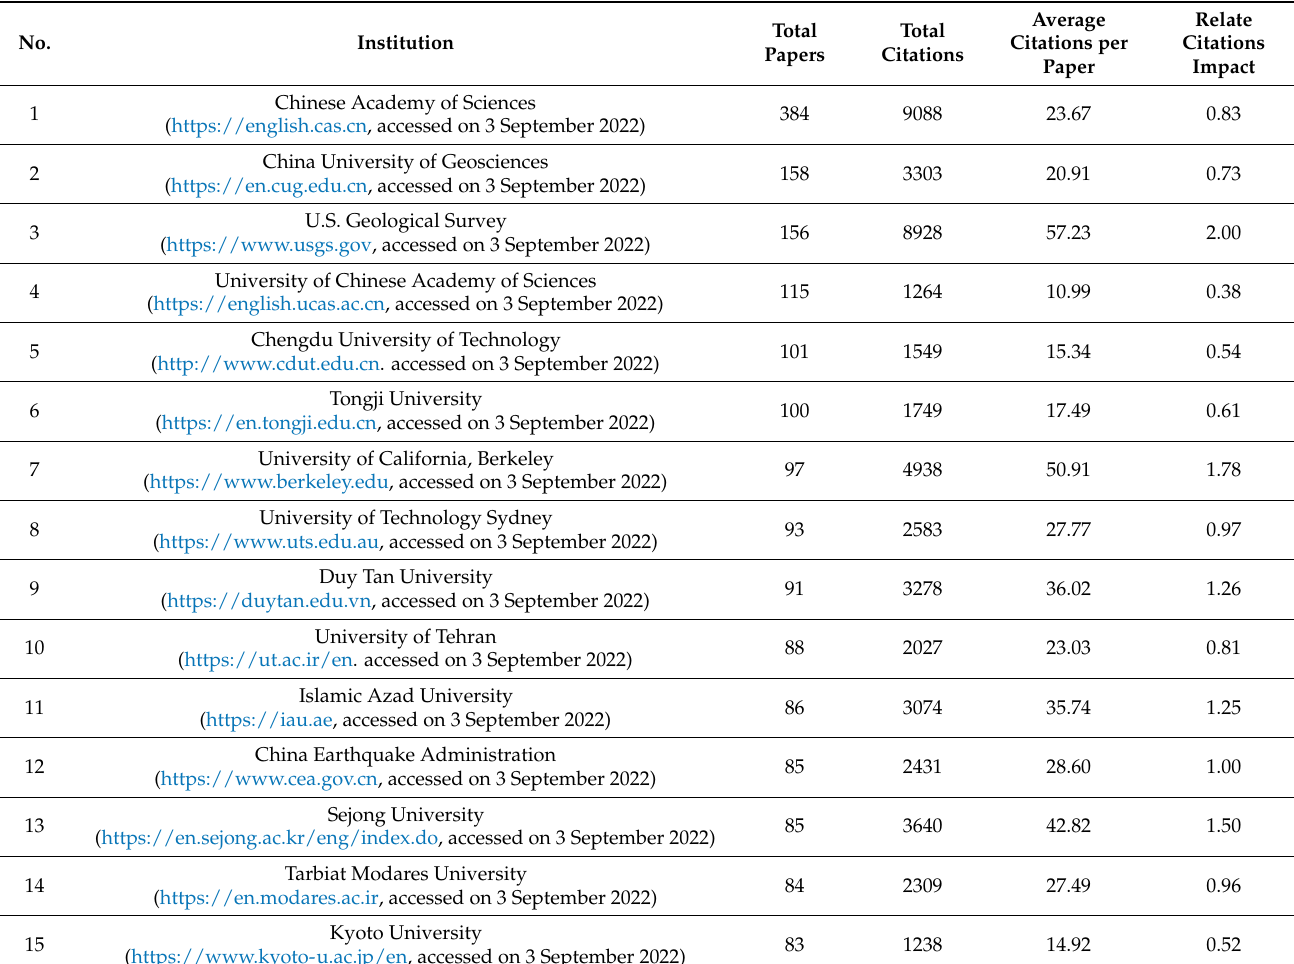
Table 3. Top 15 most productive institutions in terms of AI research in the field of geohazards